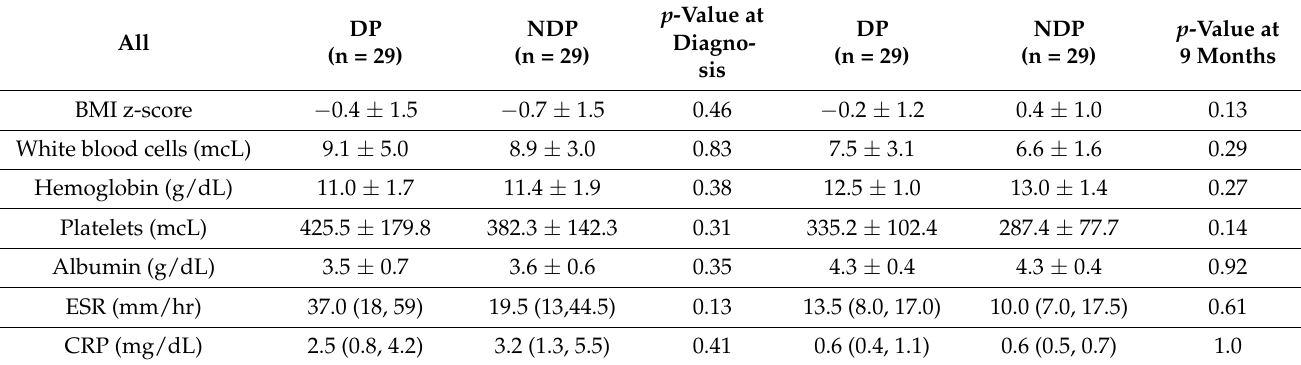
Table 2. Clinical outcomes for all patients (n = 58) at diagnosis and at 9 months post-diagnosis.